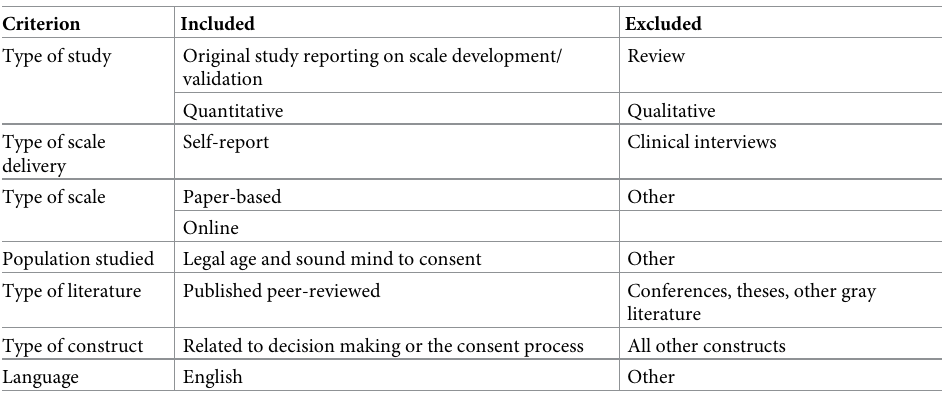
Table 1. Study inclusion and exclusion